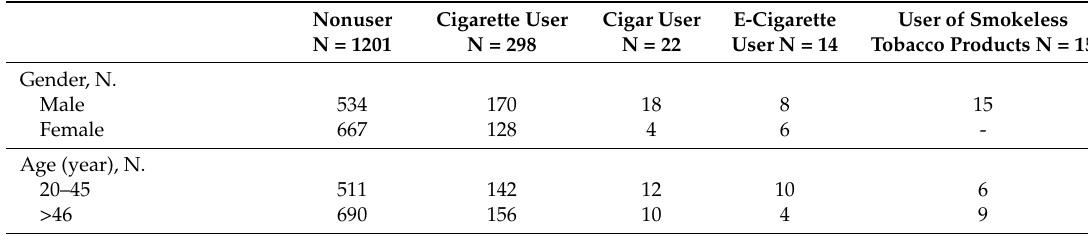
Table 1. Demographic characteristics of study